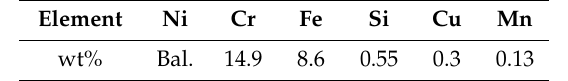
Table 1. Elemental components of the initial powder before flame spray.